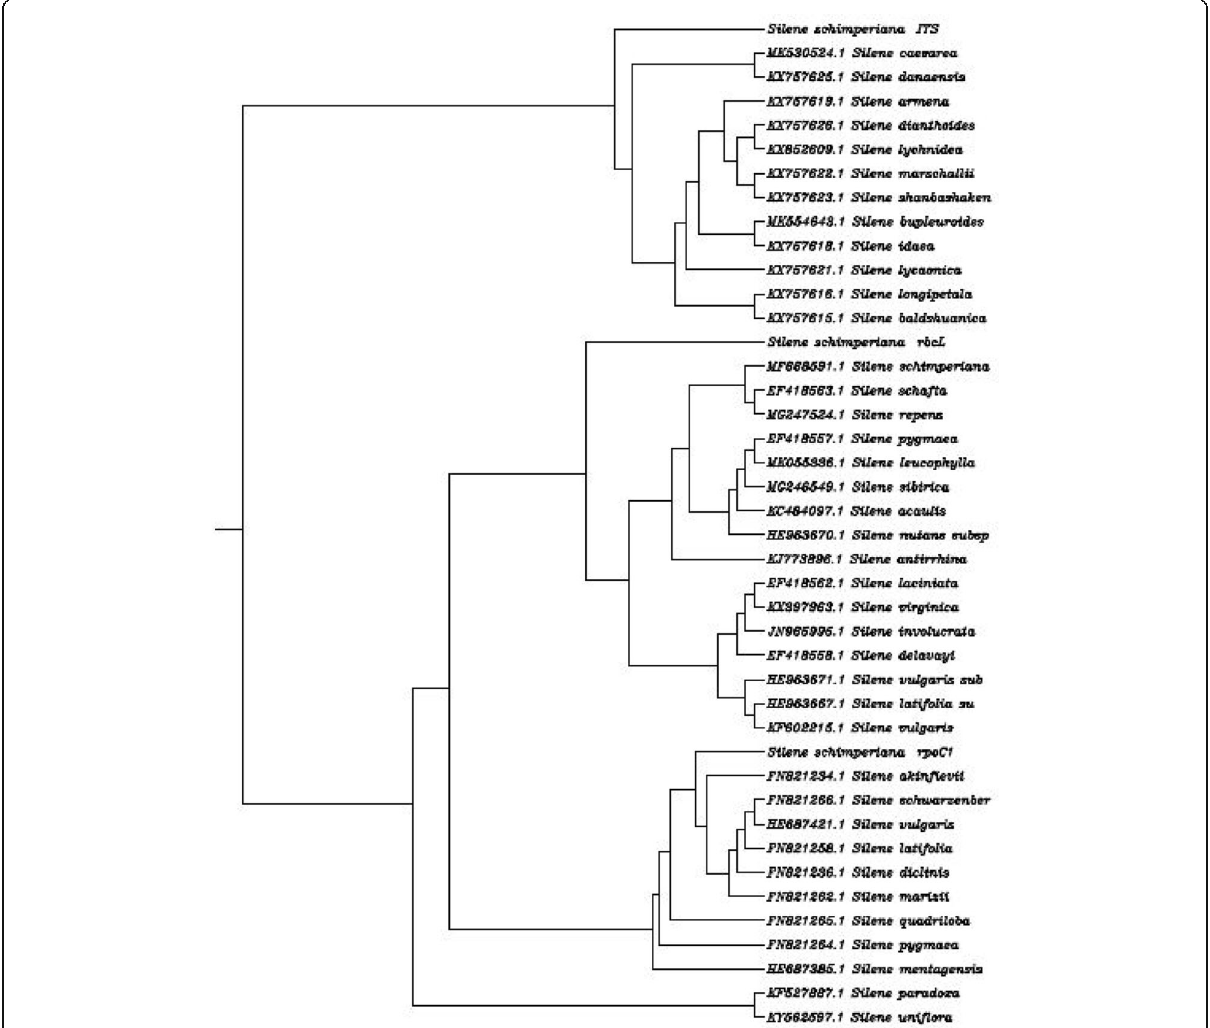
Fig. 7 Combined phylogenetic tree of Silene schimperiana using the three markers: internal transcribed spacer ( ITS ), RNA polymerase subunit ( rpoC1 ), and 1,5-bisphosphate carboxylase/oxygenase large subunit ( rbcL